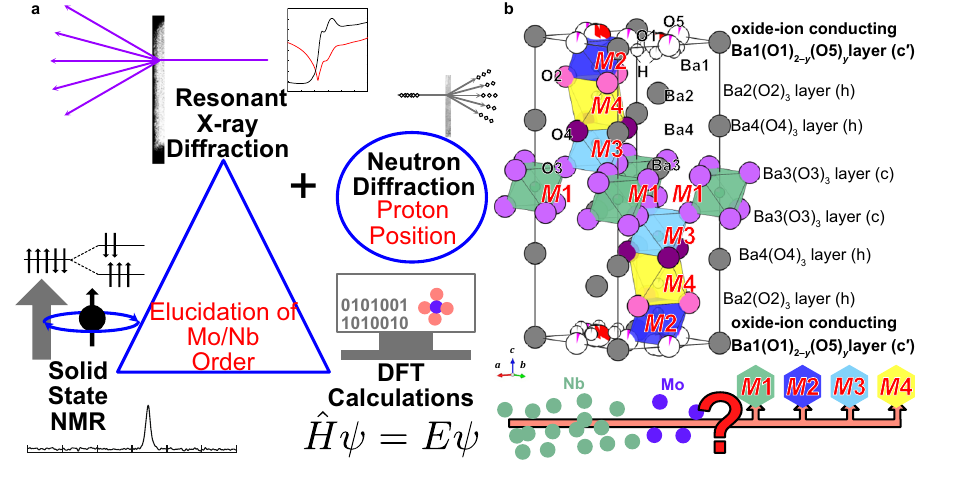
Fig. 2 | Strategies for the elucidation of the Mo/Nb order and complete crystal structure of Ba 7 Nb 4 MoO 20 ·0.15 H 2 O. a Combined technique to determine the crystal structure and Mo/Nb order of Ba 7 Nb 4 MoO 20 ·0.15 H 2 O. b Re fi ned crystal